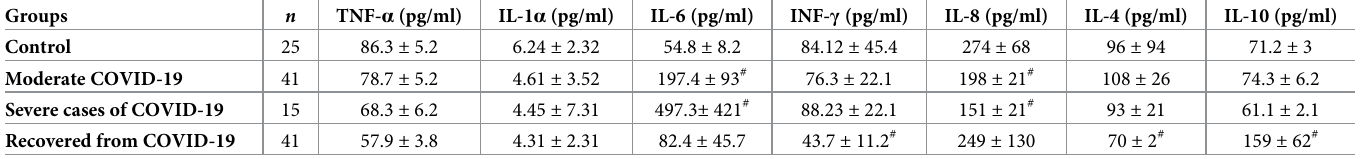
Table 2. Concentration of cytokines in the sera of enrolled participants (n = 122).